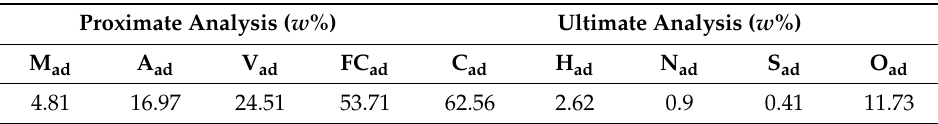
Table 1. Proximate and ultimate analyses of Yanzhou bituminous coal.